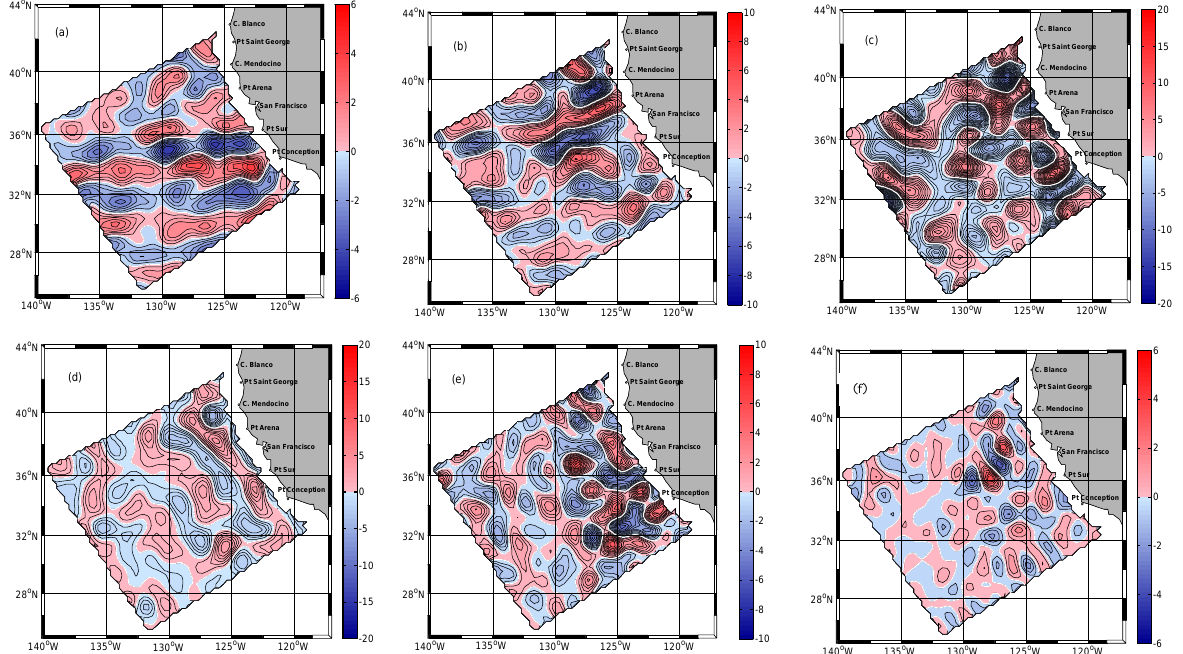
Figure 3. Characteristic spatial structures: (a) quasi-zonal jets (26 May 2006), (b) biannual oscillations (11 January 2006), (c) annual Rossby waves (4 October 2006), and (d) semiannual Rossby waves (28 November 2007). (e) and (f) : mesoscale eddies (22 November 2006 and 9 May 2006). Contour intervals are 1cm and 0.5cm in (a) – (d) and (e) and (f) , respectively. Note that the range of the contours varies from ± 6 in panels (a) and (g) to ± 10 in (b) and (e) and ± 20 in (c) and (d)